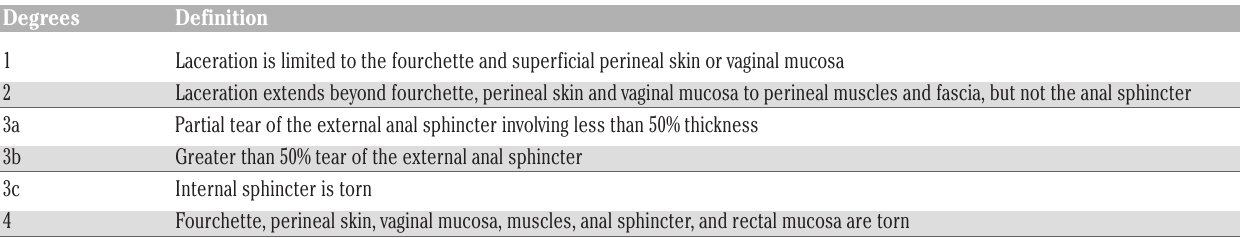
Table 1. Sultan’s classification of perineal tears in females during